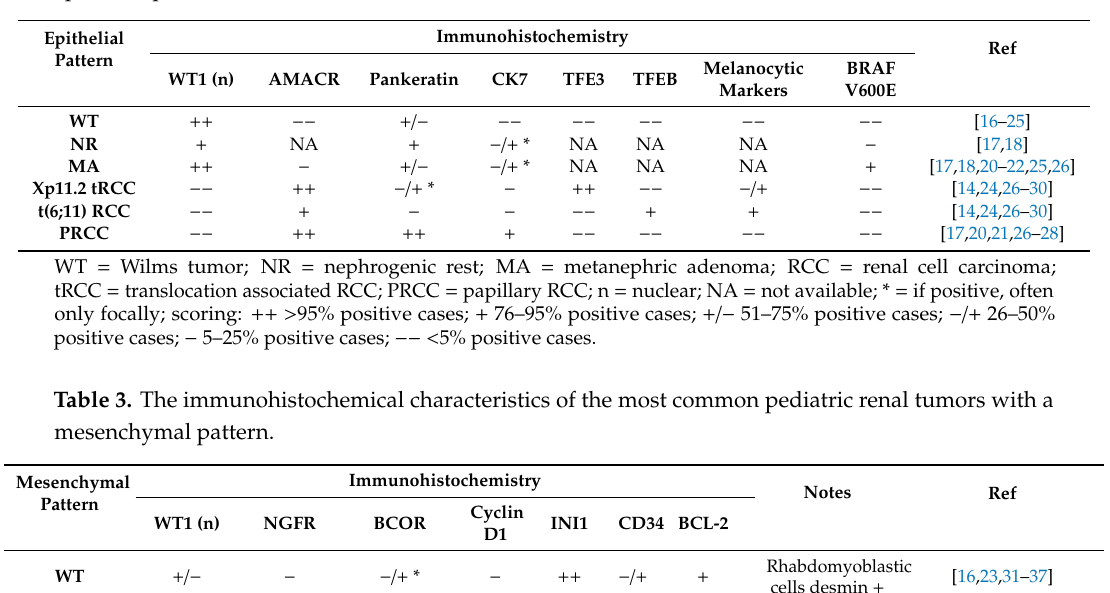
Table 2. The immunohistochemical characteristics of the most common pediatric renal tumors with an epithelial pattern.